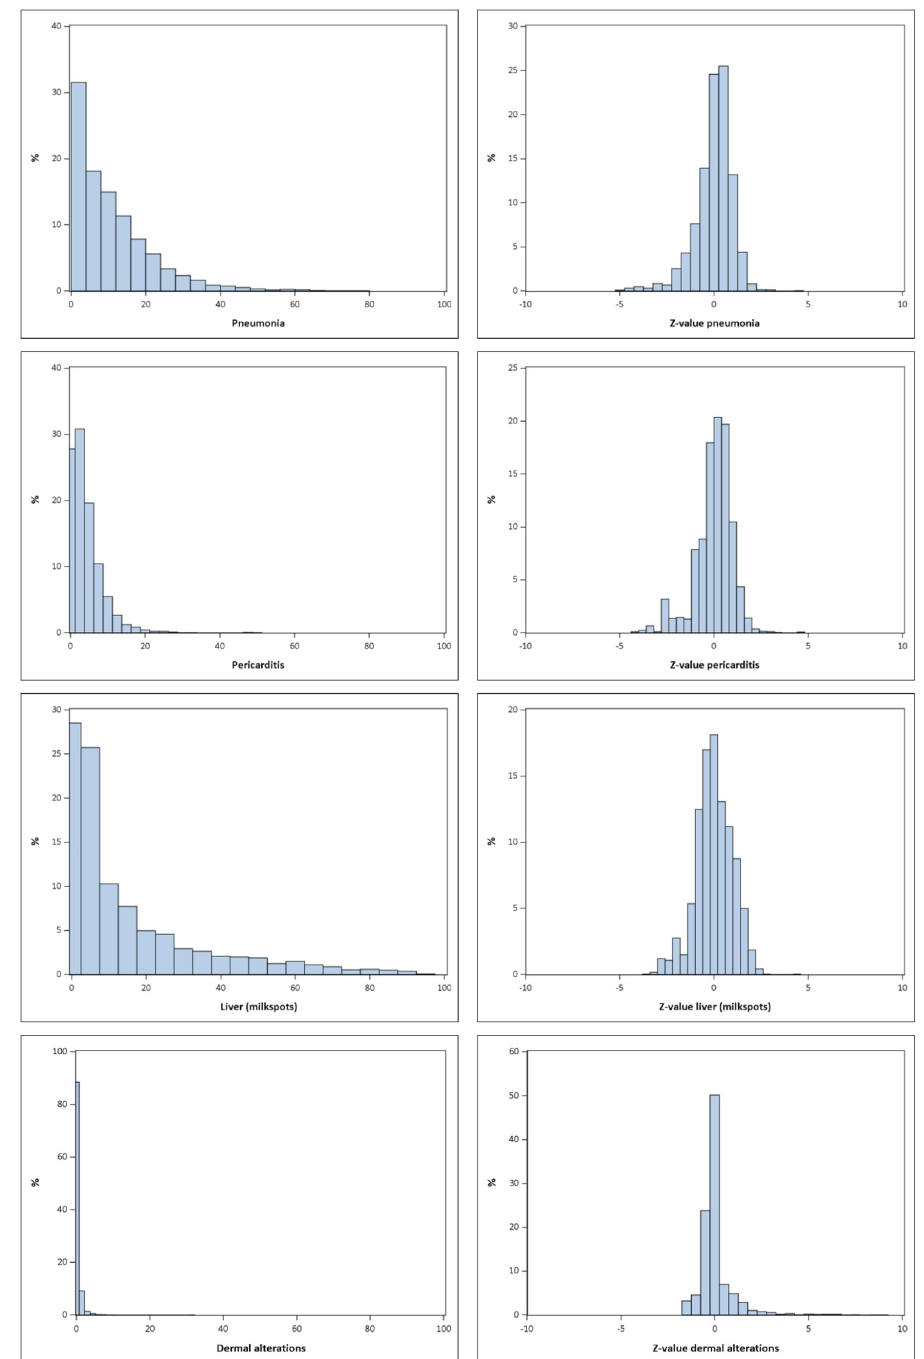
Fig 3. Distribution of the prevalence of meat inspection codes and their z-values for pneumonia, pericarditis, liver and dermal